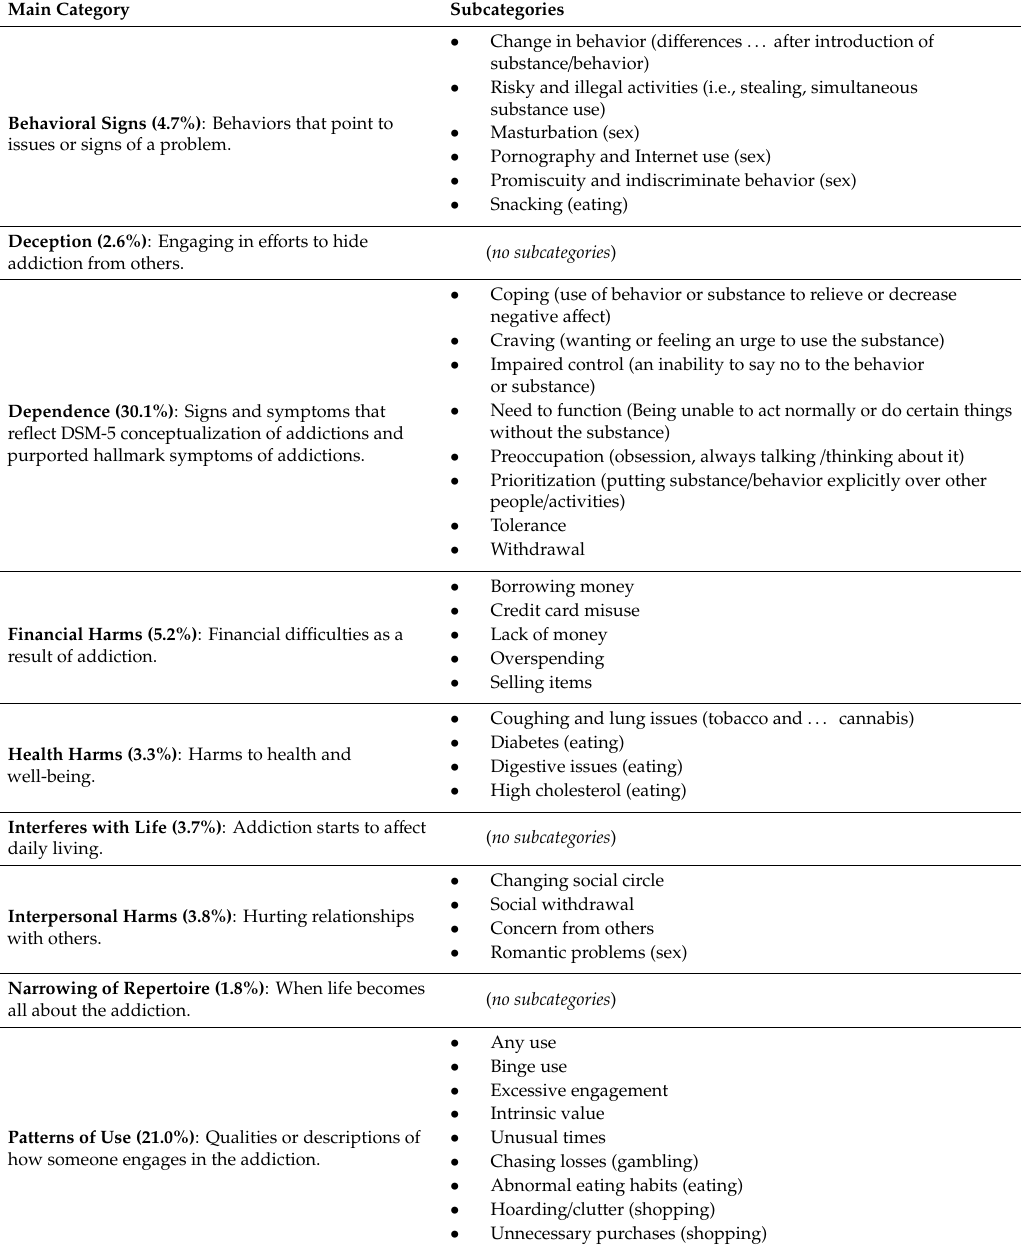
Table 1. Coding scheme consisting of main and subcategories for the 10 addictive